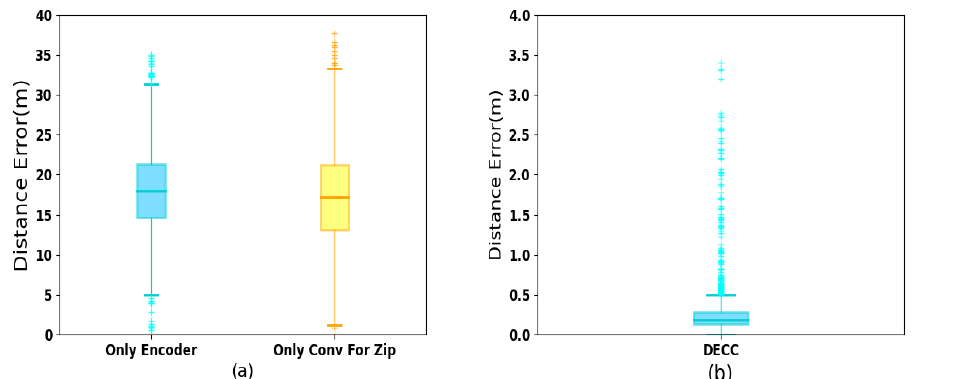
Figure 8. Ablation experiment for the DECC network: ( a ) control group 1 and 2 and ( b ) control group (‘full